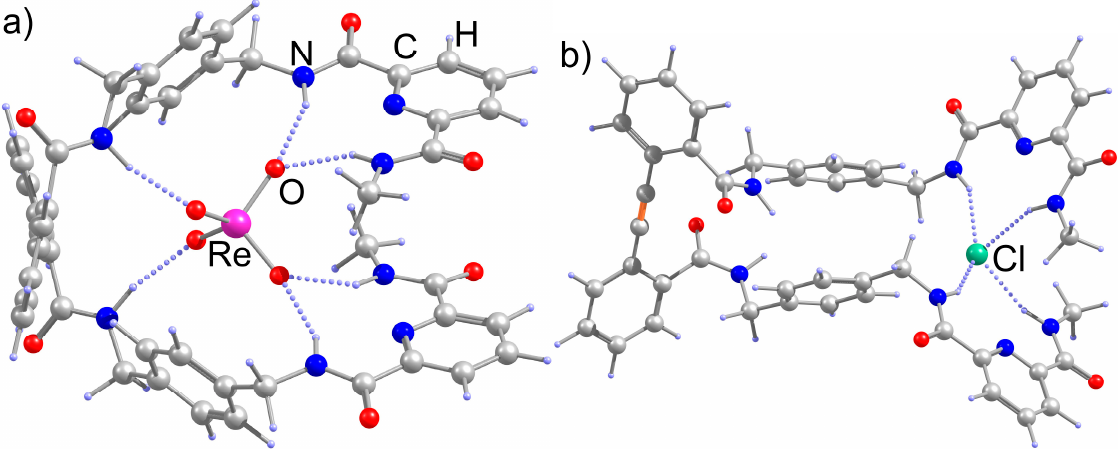
Figure 5. DFT optimized structures of receptor 2 with ( a ) perrhenate and ( b ) chloride anions, respectively.